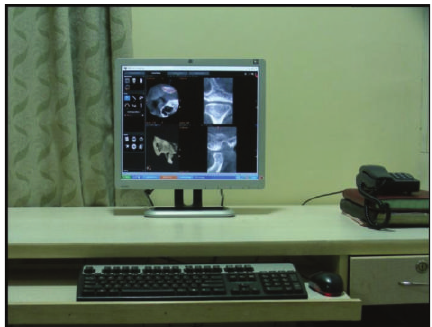
Figure 2: HP L1910 19-inch LCD Monitor used for interpretation of DVT and OPG